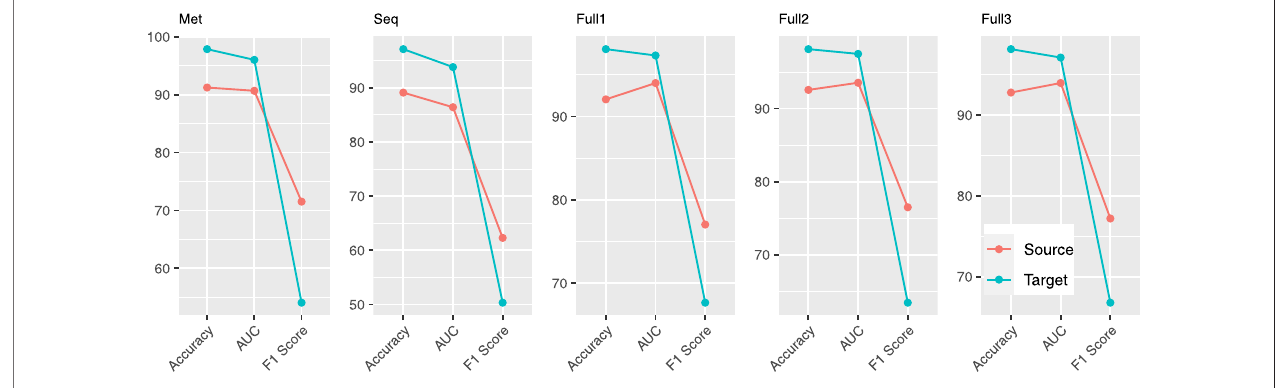
FIGURE 2 | Comparison of accuracy, AUC, and F1 score using models obtained on source and target pro fi les.